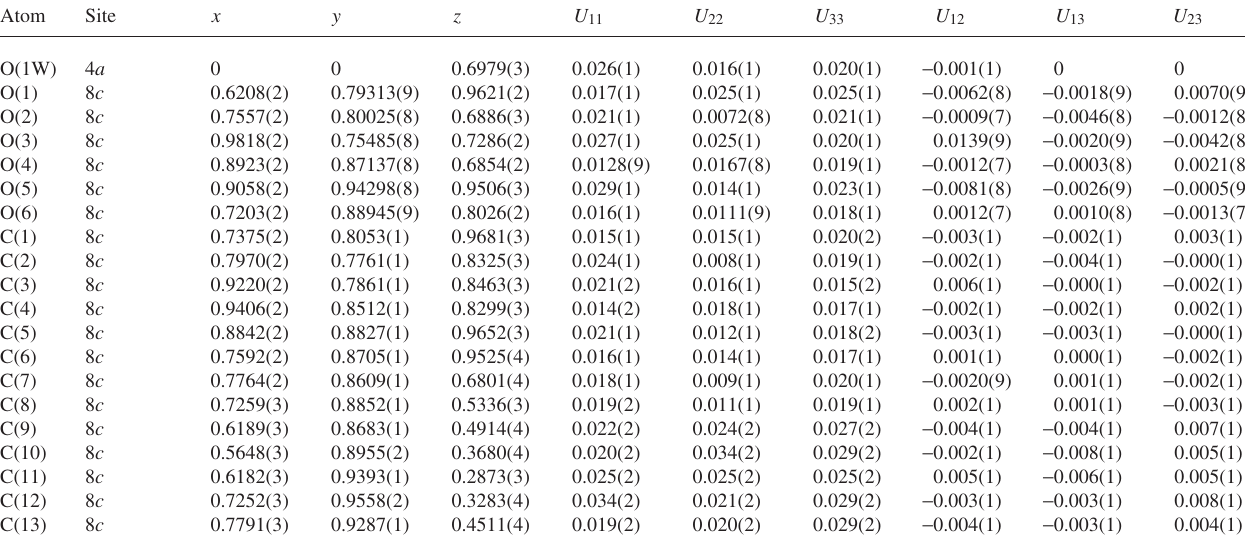
Table 3. Atomic coordinates and displacement parameters (in Å 2 )